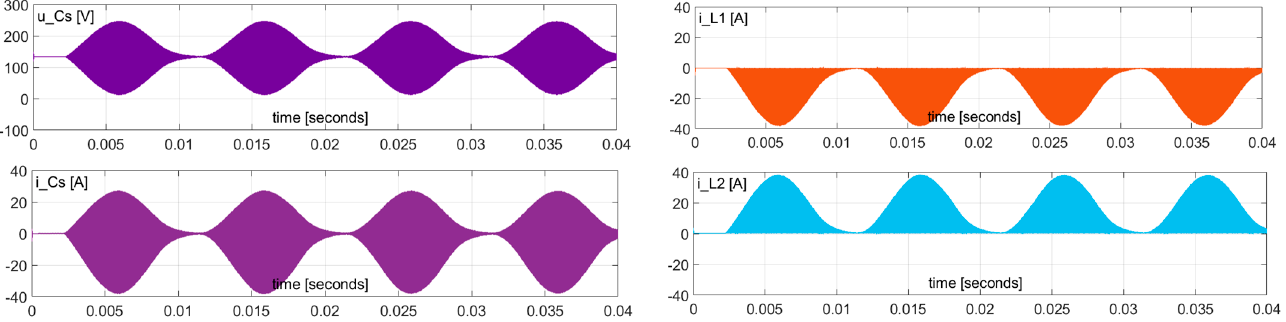
Figure 9. Steady state waveforms of the AIVB components operating with constant frequency. Voltage and current of the switched capacitor as well as currents of resonant chokes. 5 ms/div, P out = 1 kW, L f = 6 uH.